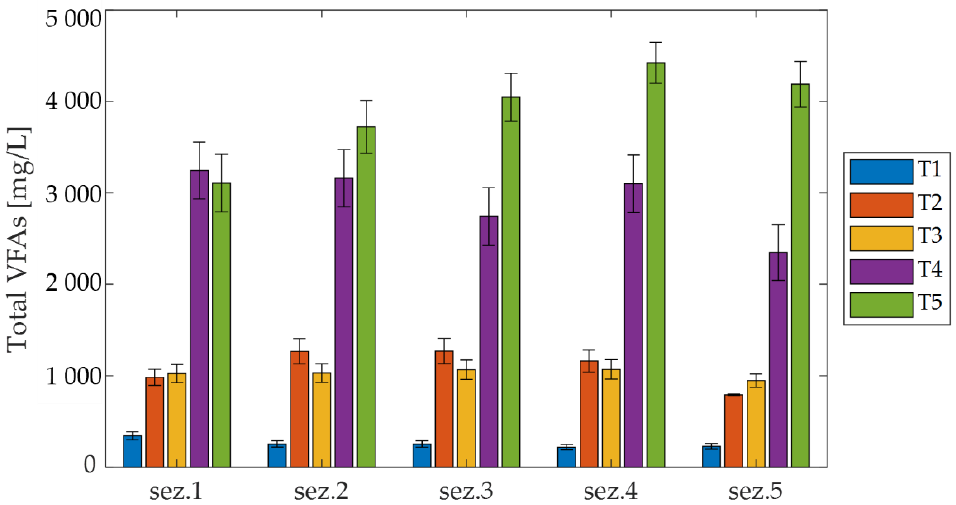
Figure 2. Total VFA concentration at sections sez.1–sez.5 in each sampling campaign.